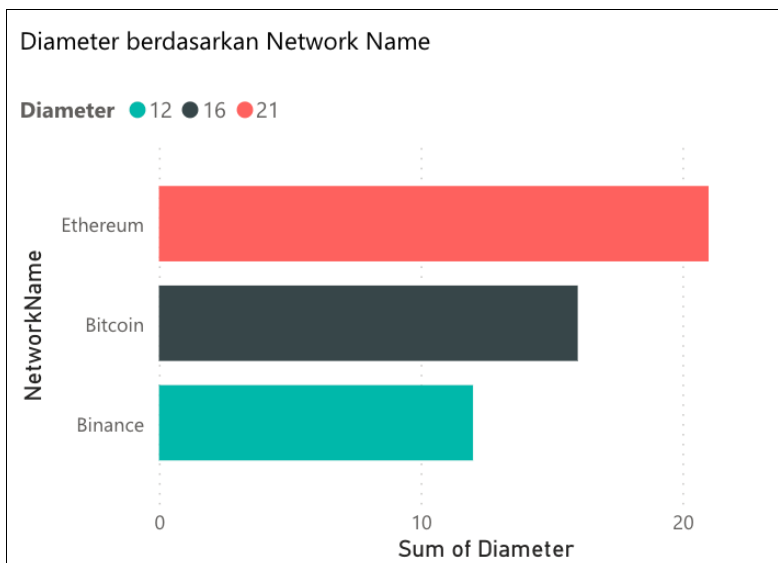
Figure 5(d). Diameter according to Cryptocurrency